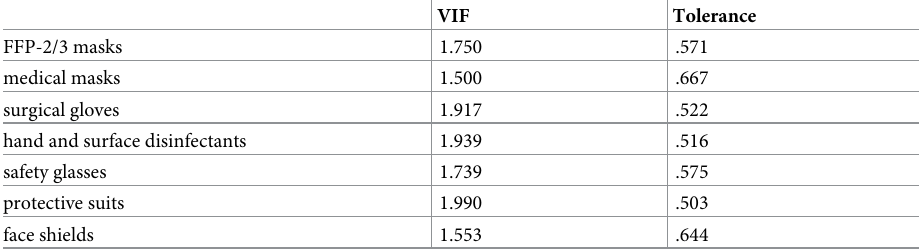
Table 2. Collinearity: Variance inflation factor and tolerance for personal protective equipment